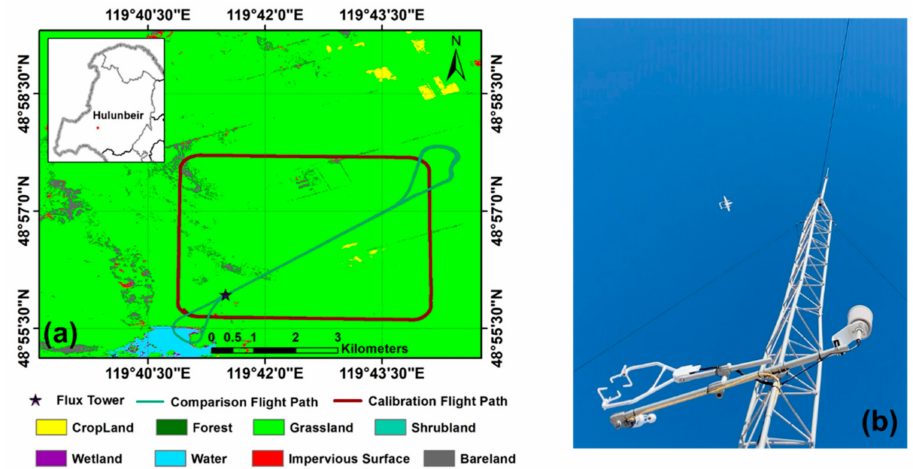
Figure 4. The flight path of the in-flight tests over the land cover classification map of the experimental area ( a ) and the scene photo during the comparison experiment ( b ).